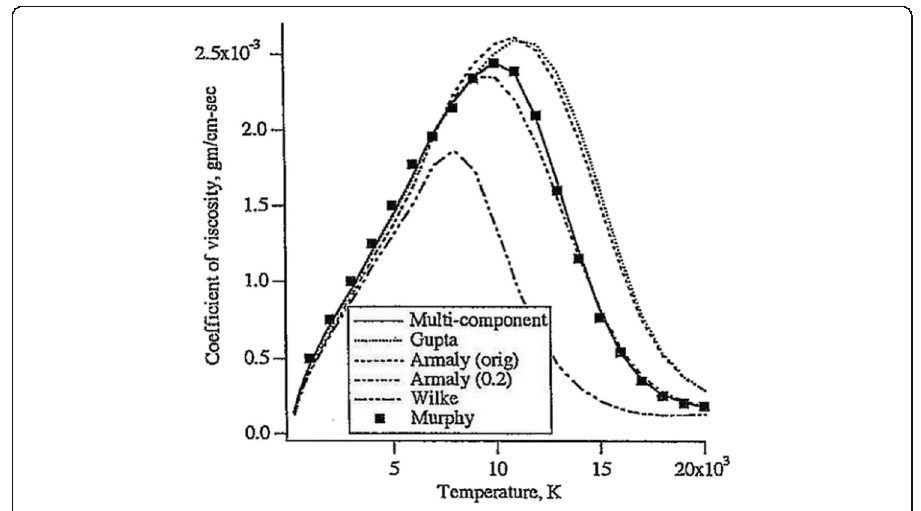
Fig. 16 Viscosity coefficient of ionized air